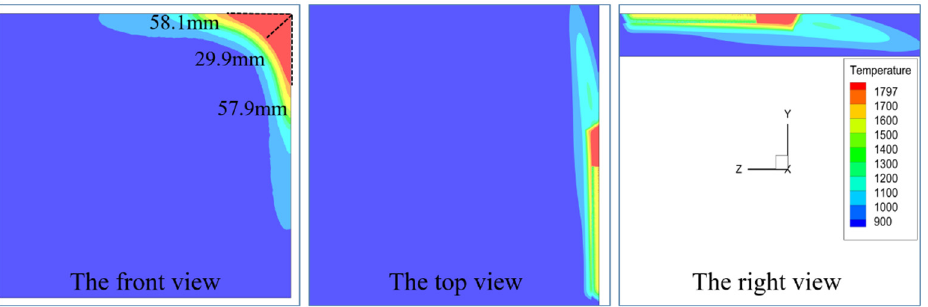
Figure 14. Three views of the front of the molten pool at 20 s.